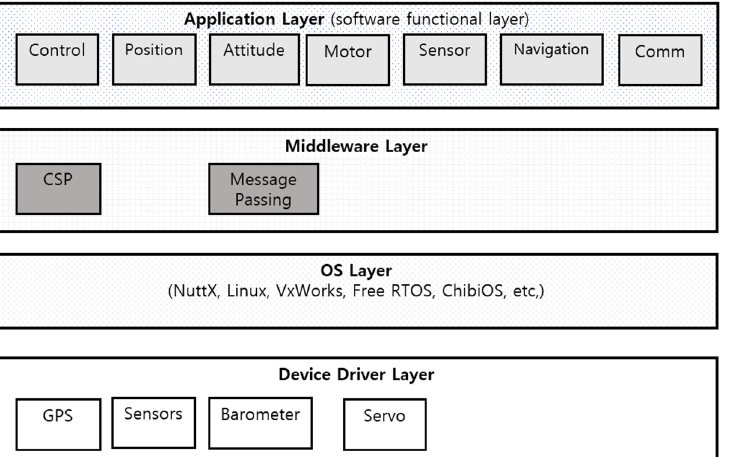
Figure 1. The most common structure of the existing software, which consists of layers and modules.